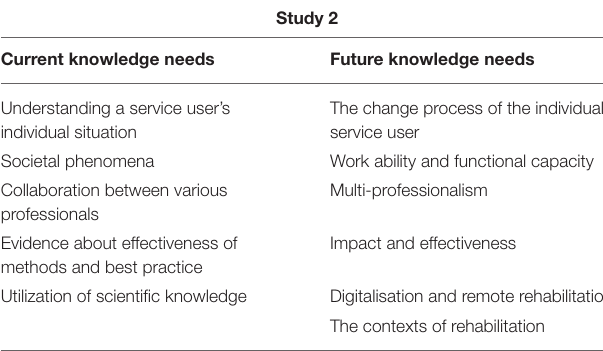
TABLE 3 | Summary of study